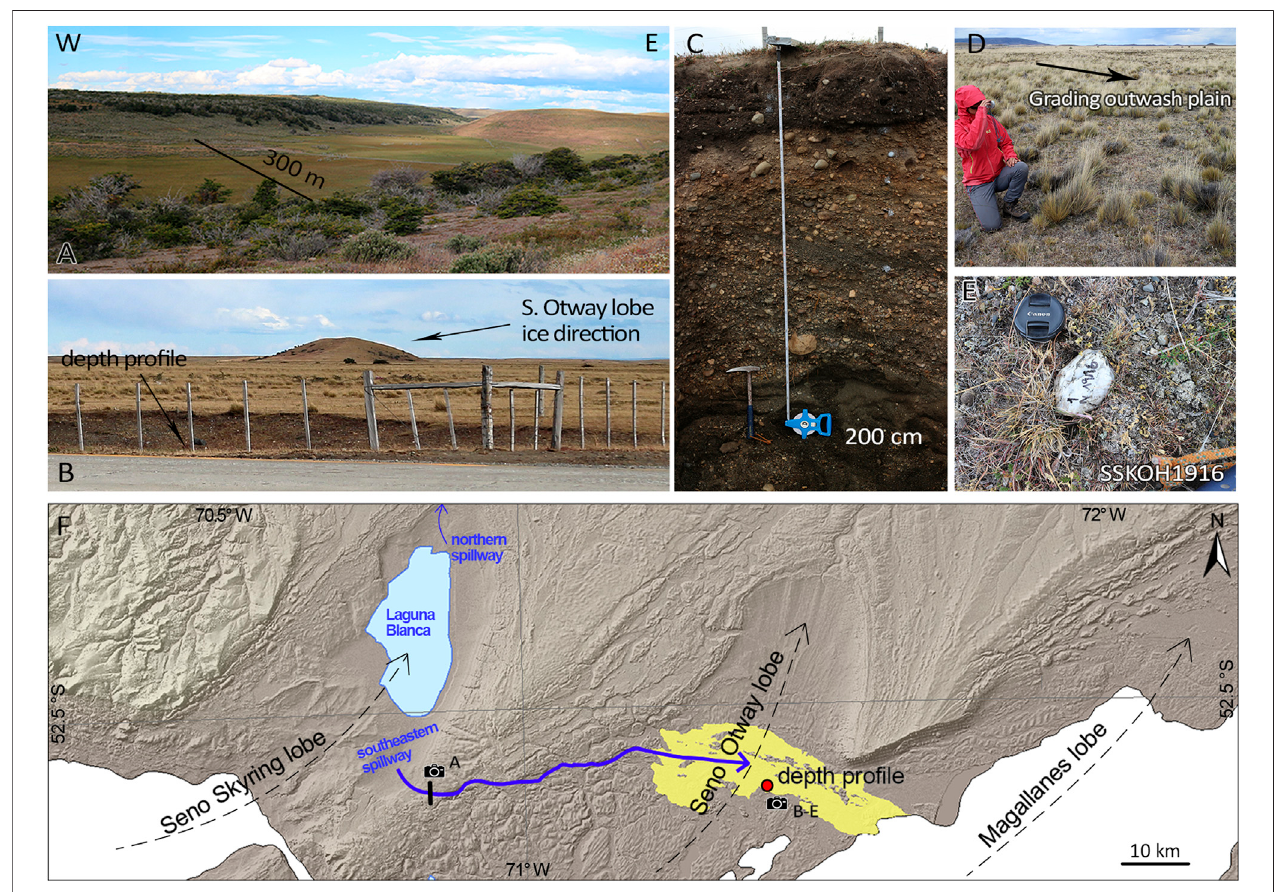
FIGURE7| Geomorphologicalrecord ofdrainage ofLaguna Blancathroughthesoutheastern spillway. (A) Southeasterndrainage spillwayviewed from thesouth. (B) Moraines of the Otway lobe surrounded and partly-buried by a later outwash deposit on both distal and proximal sides. (C) Depth pro fi le of the outwash that buries the Otway moraines. (D – E) Cobbles sampled for cosmogenic analysis on the surface of the outwash. (F) Map showing the mapped drainage route from the southeastern spillway of the Seno Skyring basin towards the Otway lobe basin.